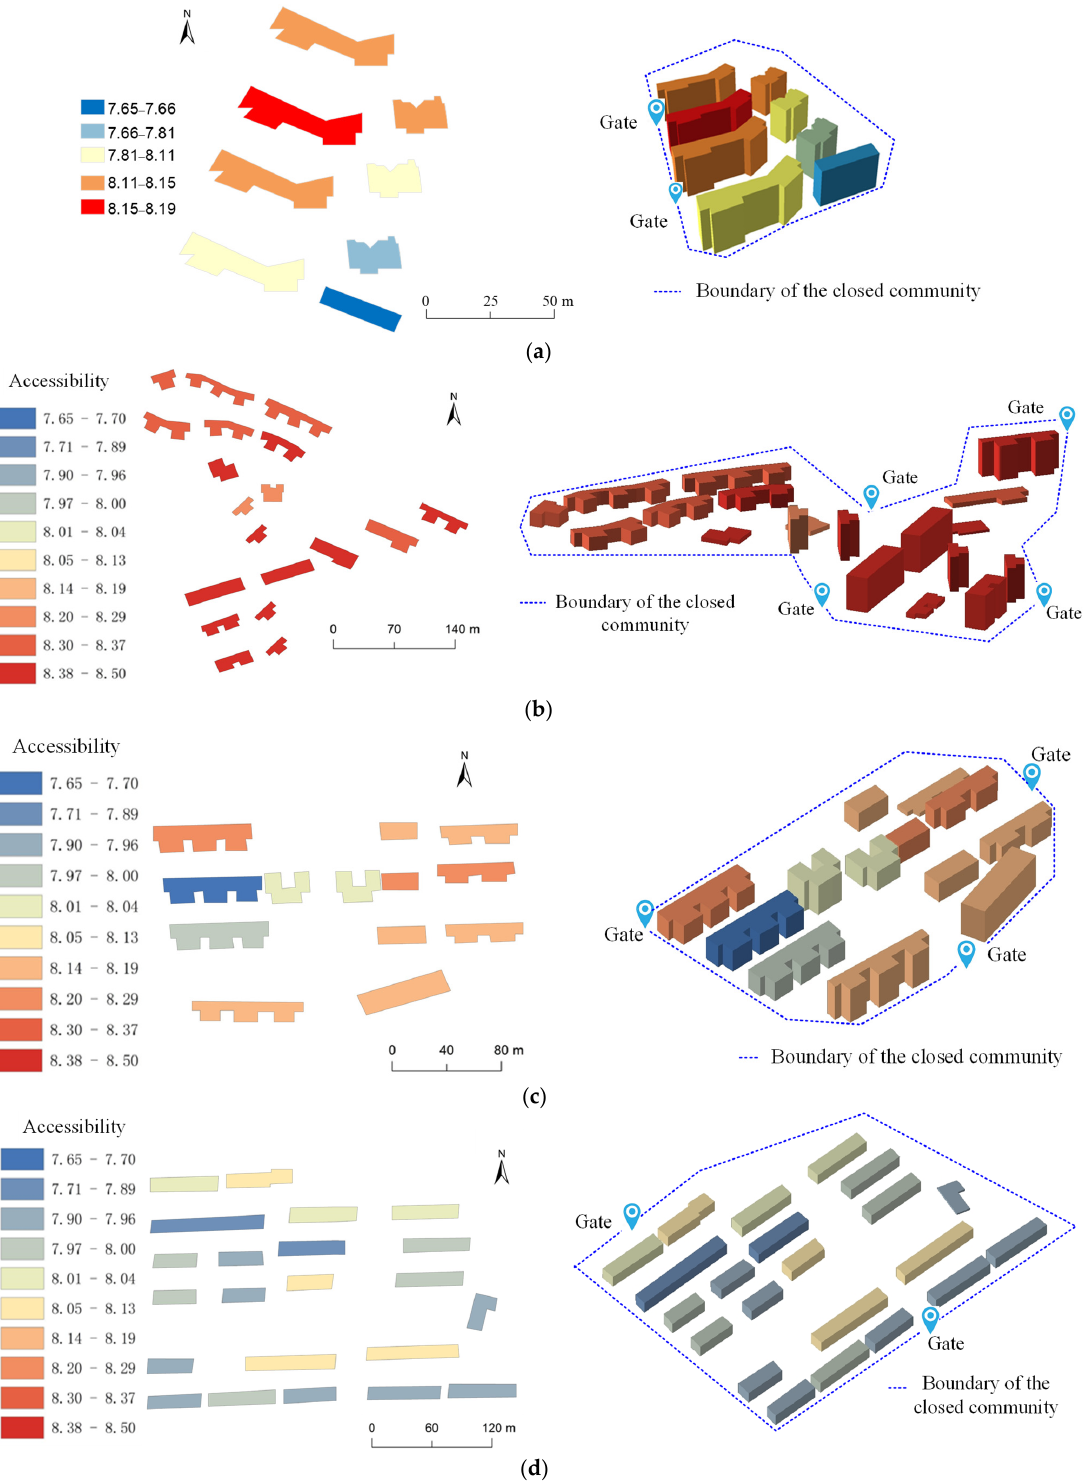
Figure 9. Accessibility measurement for four communities, ( a ) community ‘101’ in Wuchang district; ( b ) community ‘202’ in Jiangan district; ( c ) community ‘301’ in Hanyang district; ( d ) community ‘401’ in Caidian district.